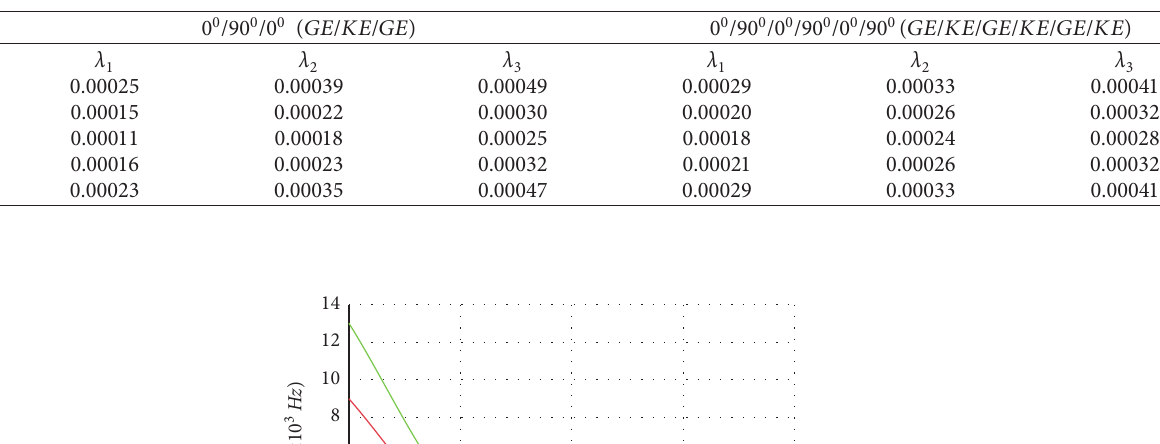
m and circumferential node number